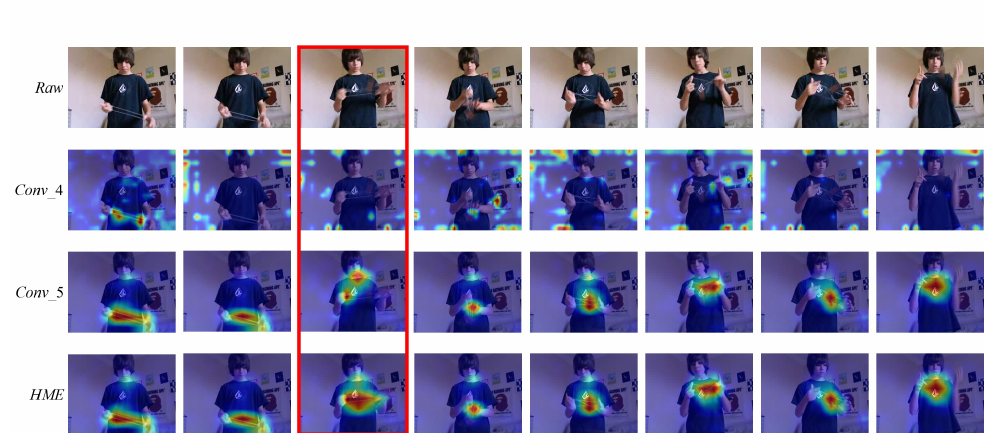
Figure 4. Visualization of significant features extracted by HME-Net for the action “YoYo” from UCF101. Features are visualized using the Class Activation Map (CAM) [42]. The second to fourth rows in the figure correspond to the output features of conv 4_ x , conv 5_ x , and the HME module, respectively. The most obvious image comparisons are marked by the red box. Comparing these sub-graphs, it can be noticed that the HME module was able to extract features that are related to movements. This is because the HME module captures feature-level motion information.